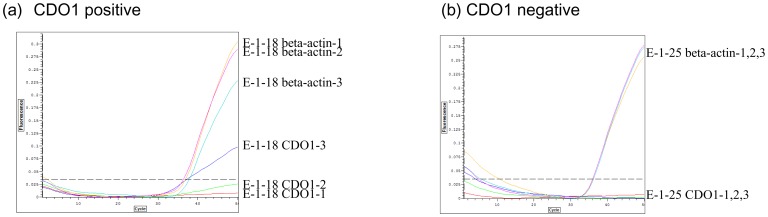
Q-MSP analysis of methylated CDO1 in plasma using a low volume of template DNA (termed one template volume).(a) A representative positive case was shown. The β-actin gene was assayed as an internal control for bisulfite treated DNA. Even for this positive case, detection of methylated CDO1 is not stable, because all the templates did not overcome the threshold level. (b) A representative negative case is shown. Note that the β-actin level is lower than expected.